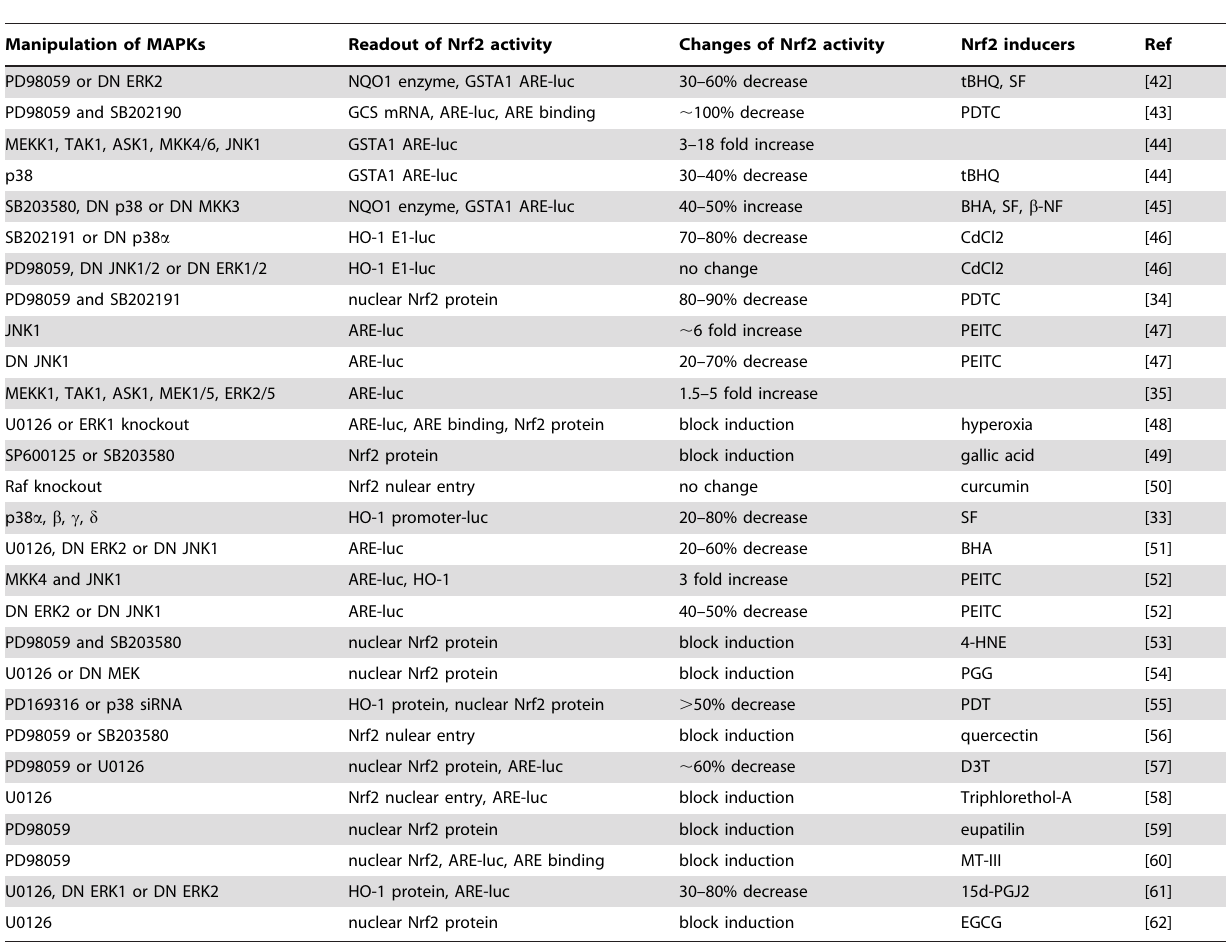
Table 1. Summary of key findings by previous studies showing the involvement of MAPKs in Nrf2